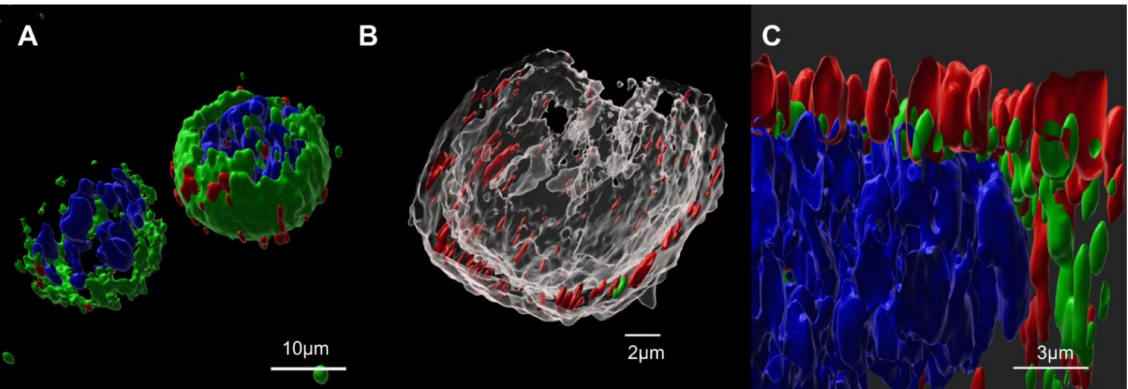
Figure 1. Spike protein cellular localization. Cells were treated with an anti-SARS-CoV-2 S1 spike sub- unit monoclonal antibody, followed by an Cy5 anti-human secondary incubation. ( A ): Co-localization of spike (red) and Gag (green) can be observed at cells’ external boundary. Cell nuclei were stained and shown as blue. ( B ): By staining the lipid membrane with CellMask, the strong co-localization of S protein (red) and cell membrane (grey) was observed. ( C ): Cross-sectional observation of the plasmatic membrane, where the co-localization of spike (red) and Gag (green) can be observed. Cell nuclei were stained and shown as